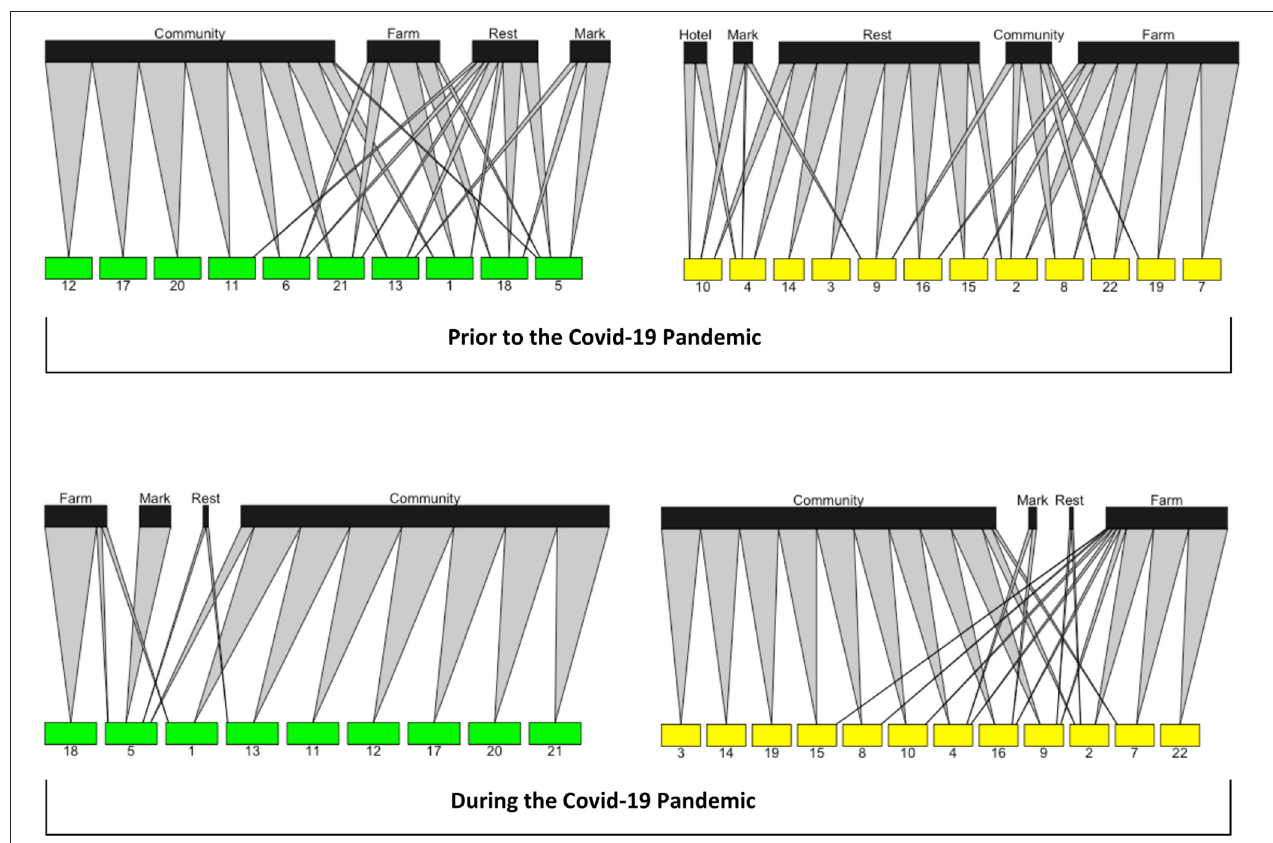
FIGURE 2 | The distribution of crop sales between each respondent [lower boxes; green = K¯anaka ‘ ¯ Oiwi Farmers (KF) and yellow = Non-Indigenous Local Farmers (LF)] and different consumer base types [community (e.g. CSA boxes, farm pick ups, and donations), supermarkets (Mark), farmers markets (Farm), restaurants (Rest), and hotels] prior to and during the COVID-19 pandemic. The links between the two represent the proportion of pounds distributed to that consumer base relative to the overall pounds harvested by each